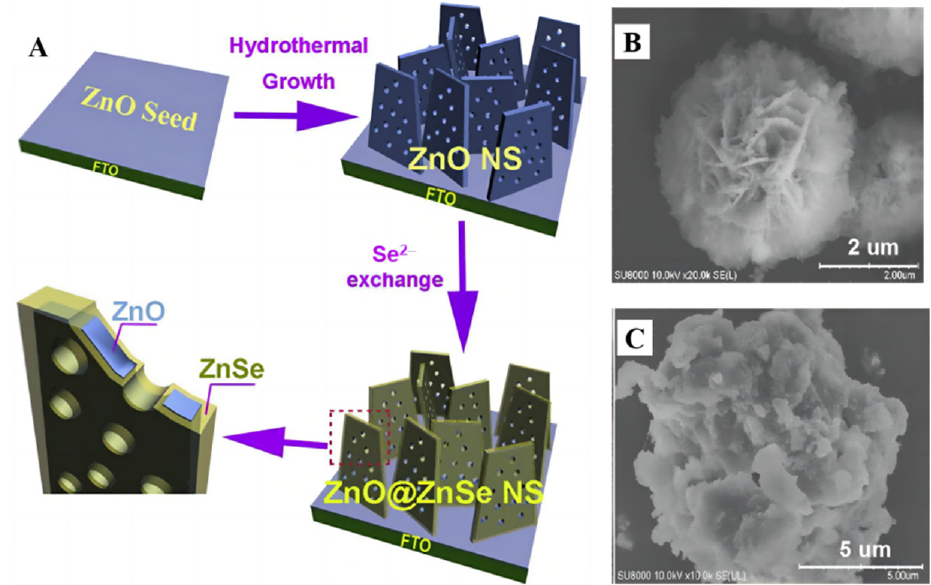
Figure 12. ( A ) Schematic illustration of the fabrication process of ZnO@ZnSe photocathode [88] ( B ) ZnO/ZnS ( C ) ZnO/ZnS/g-C 3 N 4 SEM images [91]. ( B ) ZnO/ZnS ( C ) ZnO/ZnS/g-C 3 N 4 SEM images